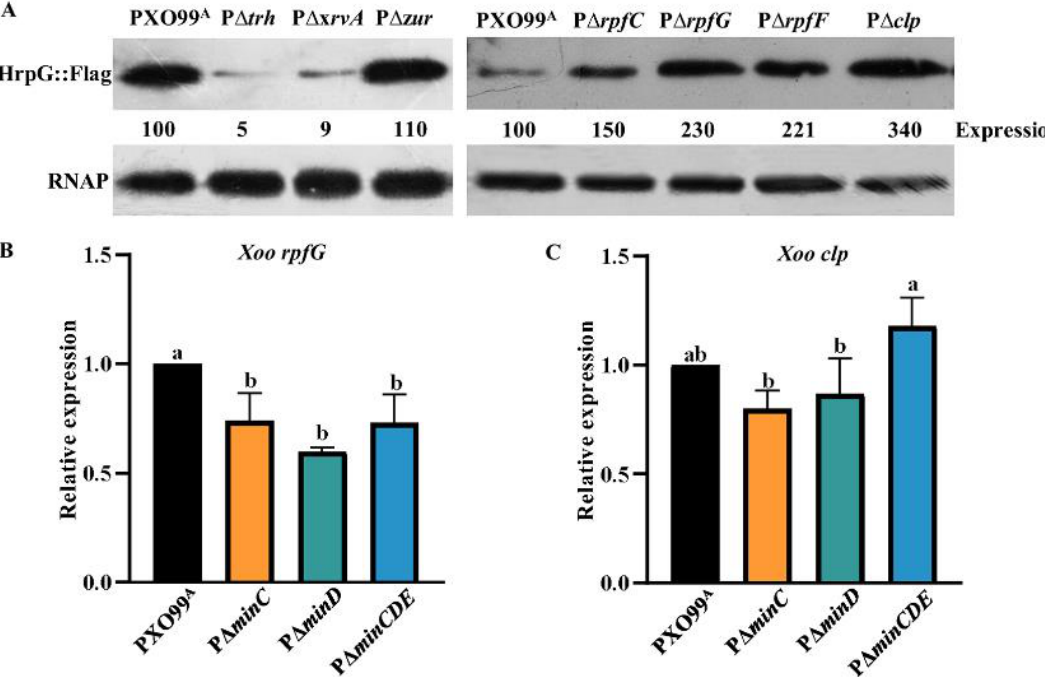
Figure 3. HrpG expression levels in the mutants of Xoo virulence regulator genes and the rpfG and clp expression levels in the Min mutants. ( A ) The abundance of HrpG proteins in PXO99 A , P ∆ trh , P ∆ xrvA , P ∆ zur , P ∆ rpfC , P ∆ rpfG , P ∆ rpfF , and P ∆ clp by Western blotting. The total protein extracts were analyzed by Western blotting using anti-FLAG antibodies. RNAP, RNA polymerase subunit alpha from E . coli was used as a loading control. Relative protein abundance was calculated by ImageJ software. Similar results were observed in two independent experiments. ( B ) Expression ratios of rpfG in P ∆ minC , P ∆ minD , and P ∆ minCDE compared to that in Xoo wild-type PXO99 A by qRT-PCR. ( C ) Expression ratios of clp in P ∆ minC , P ∆ minD , and P ∆ minCDE compared to that in PXO99 A by qRT-PCR. Similar results were observed in more than three independent experiments. As assessed by Duncan’s test, different letters indicate statistically significant differences, and the same letter displays no significant differences ( p < 0.05) between Xoo